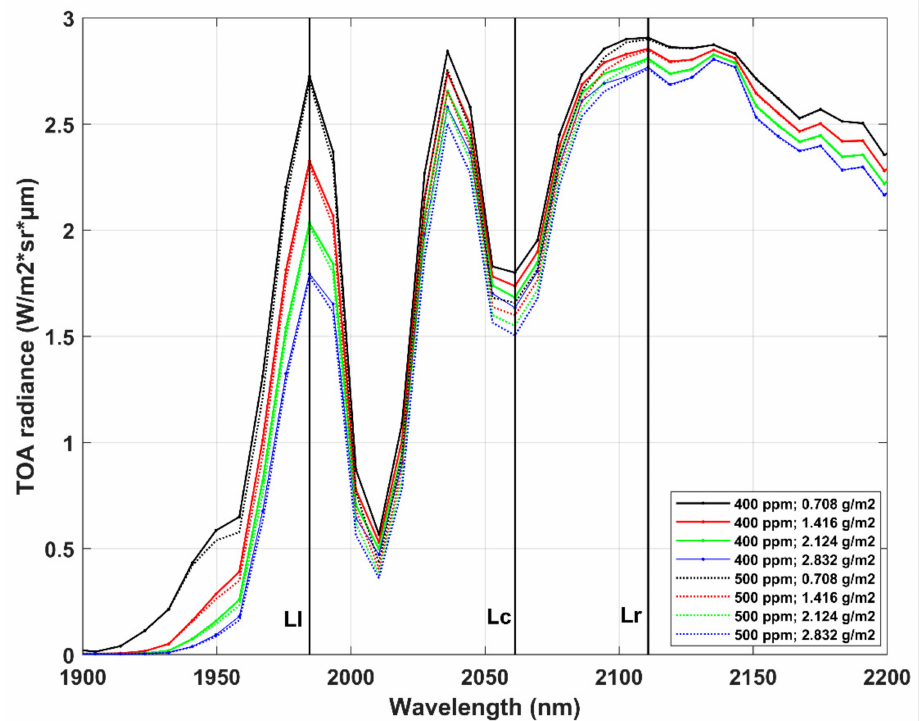
Figure 3. Simulated TOA spectral profiles convolved on PRISMA channels, for two CO 2 column- averaged values (400, 500 ppm) and four H 2 O column amounts (0.708, 1.416, 2.124, 2.832 g/m 2